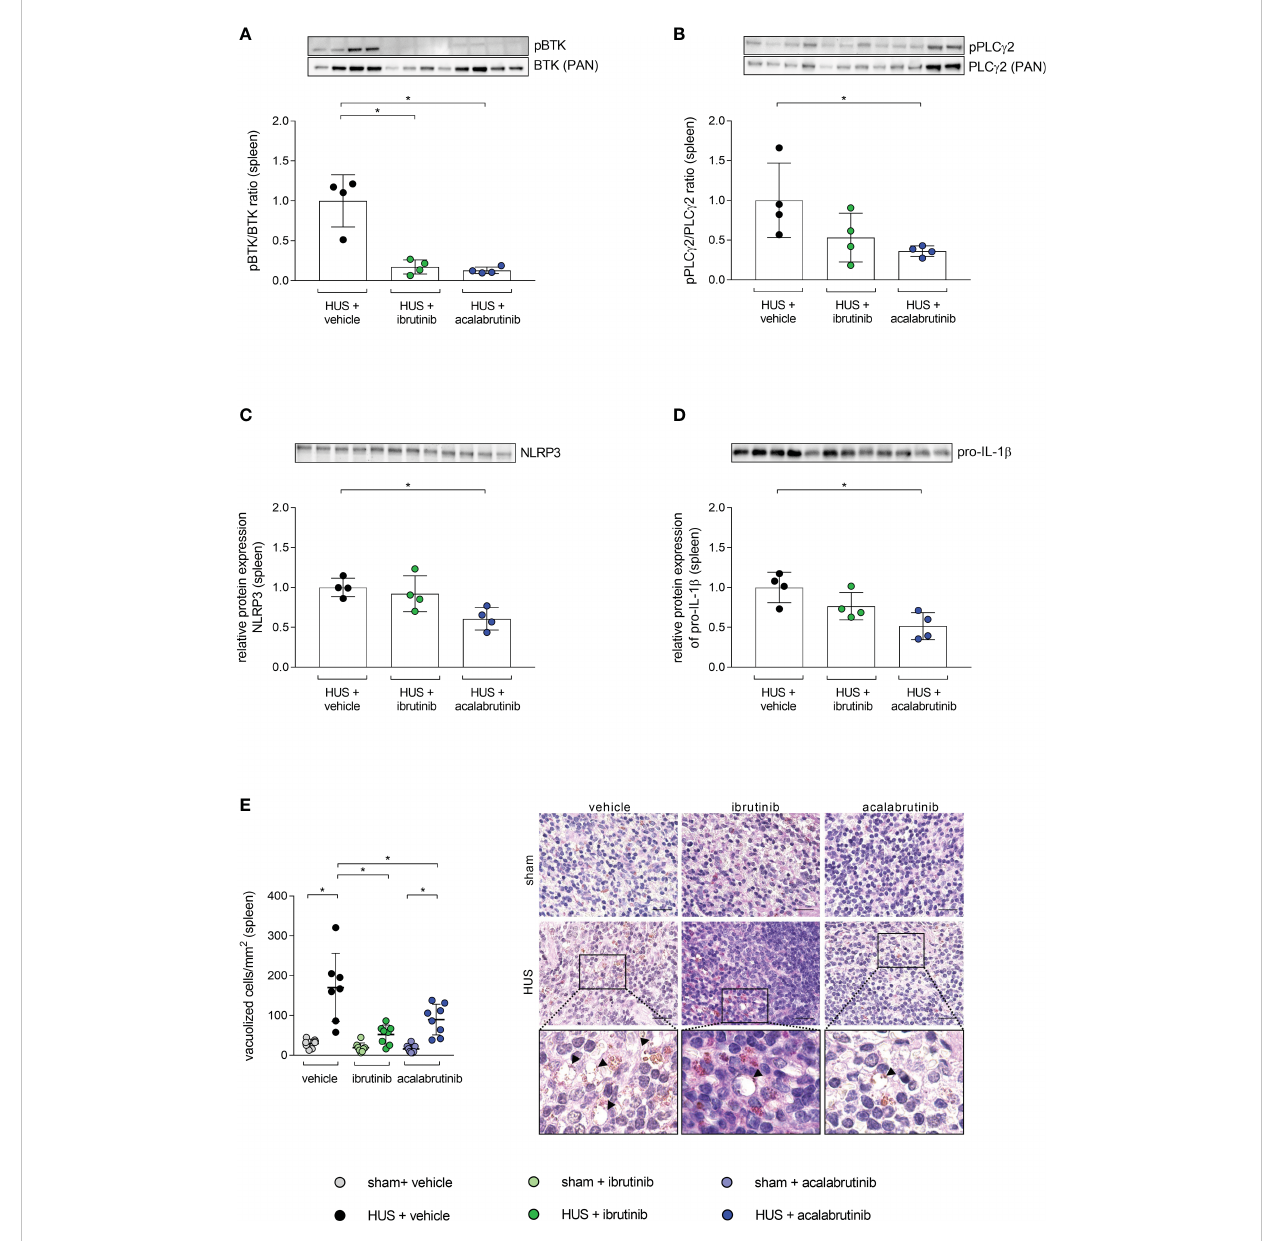
FIGURE 5 BTK-downstream signaling as well as vacuolization of cells in spleen of mice with HUS treated with ibrutinib or acalabrutinib. Ratio of relative phosphorylated protein expression to relative pan protein expression of (A) BTK and (B) PLC g 2 as well as relative protein expression of (C) NLRP3 and (D) pro-IL-1 b in spleen (n = 4 per HUS group) in whole splenic protein lysates on humane endpoint or day 7. Quanti fi cation and representative images of (E) vacuolization of cells in splenic sections (n = 7 - 8 per group) on humane endpoint or day 7. Bars = 20 µm (1000x magni fi cation). Arrows indicate sites of vacuolization. Data are expressed as scatter dot plot with mean + SD. (A – D) Mann-Whitney-U test. (E) ordinary one-way ANOVA + Holm-Sidak ’ s multiple comparison test. *P < 0.05. BTK, Bruton ’ s tyrosine kinase; PLC g 2, phospholipase-C-gamma2; HUS, hemolytic- uremic syndrome; NLRP3, NLR family pyrin domain containing 3; IL-1 b ,